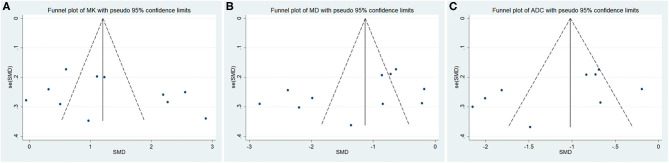
Funnel plot of the (A) mean kurtosis (MK), (B) mean diffusivity (MD), and (C) apparent diffusion coefficient (ADC). No publication bias was observed.